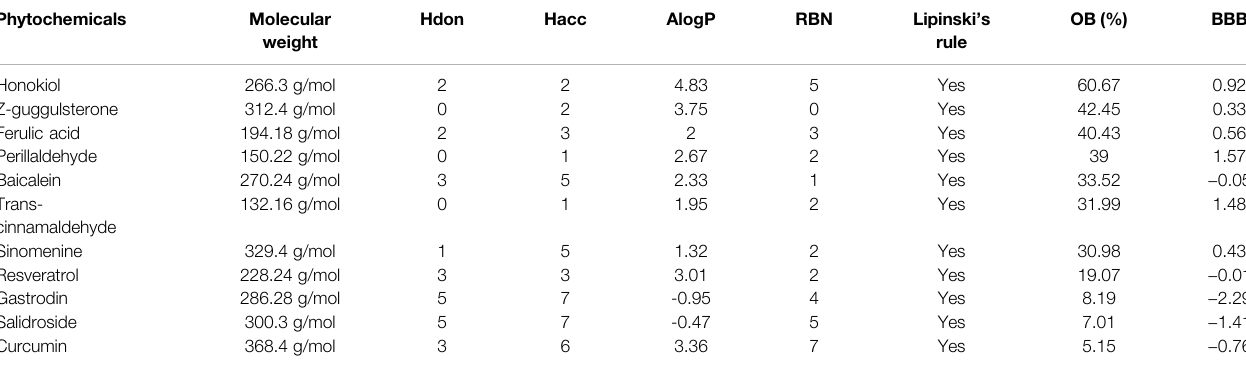
TABLE 5 | Potential phytochemicals screened by Lipinski ’ s rule.